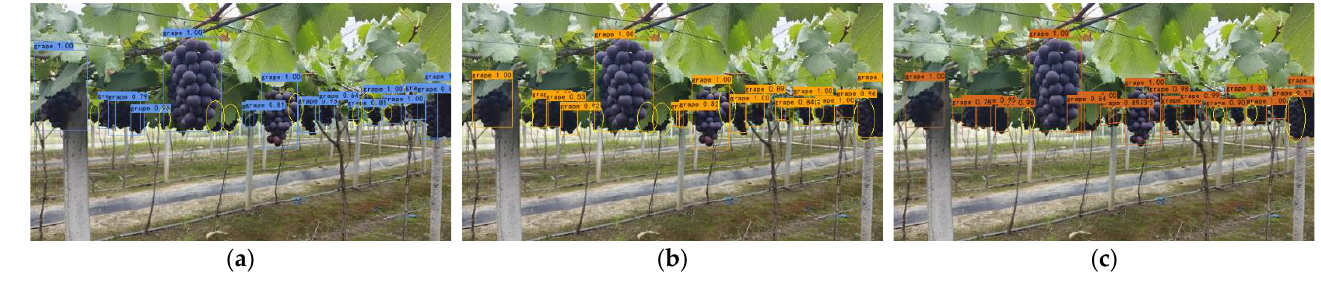
Figure 15. Actual detection grape results of the medium network models: ( a ) YOLOv3 ( b ) YOLOv4 ( c ) YOLOv5m. The yellow ellipse represents the missed detection of grapes. Table 10. Number of grape clusters detected by 13 network models.